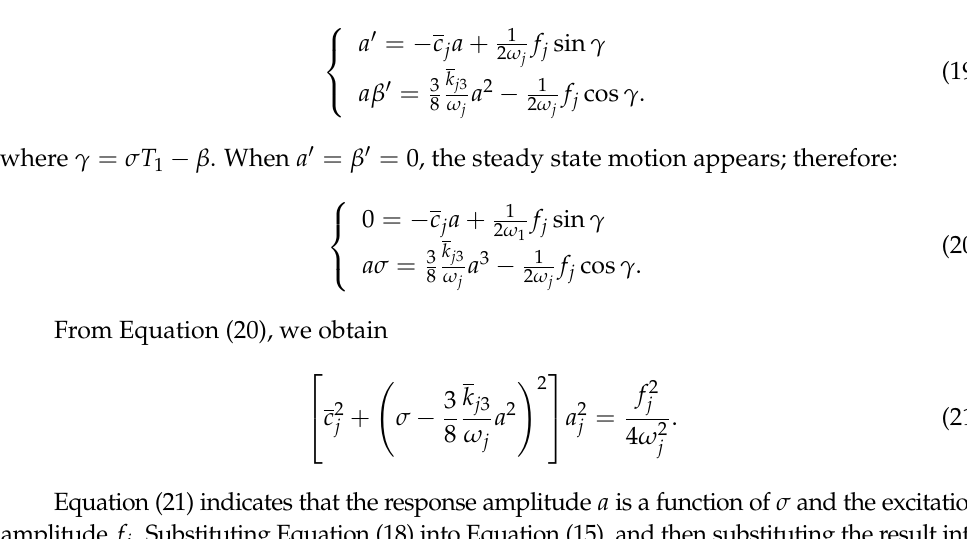
Figure 5. Frequency − Response curves of the first mode with (